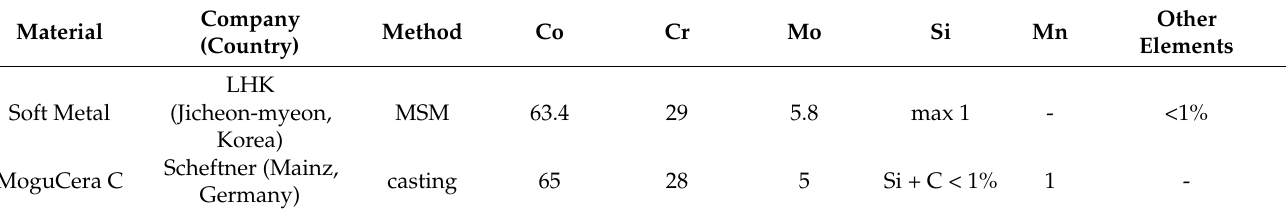
Table 1. The chemical composition of alloys